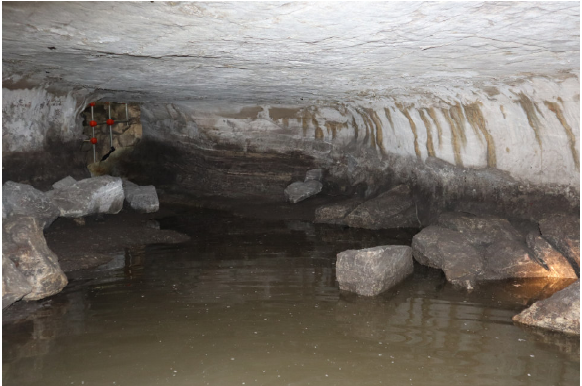
Figure 5 . The main entrance with the greatest concentration of slabs and